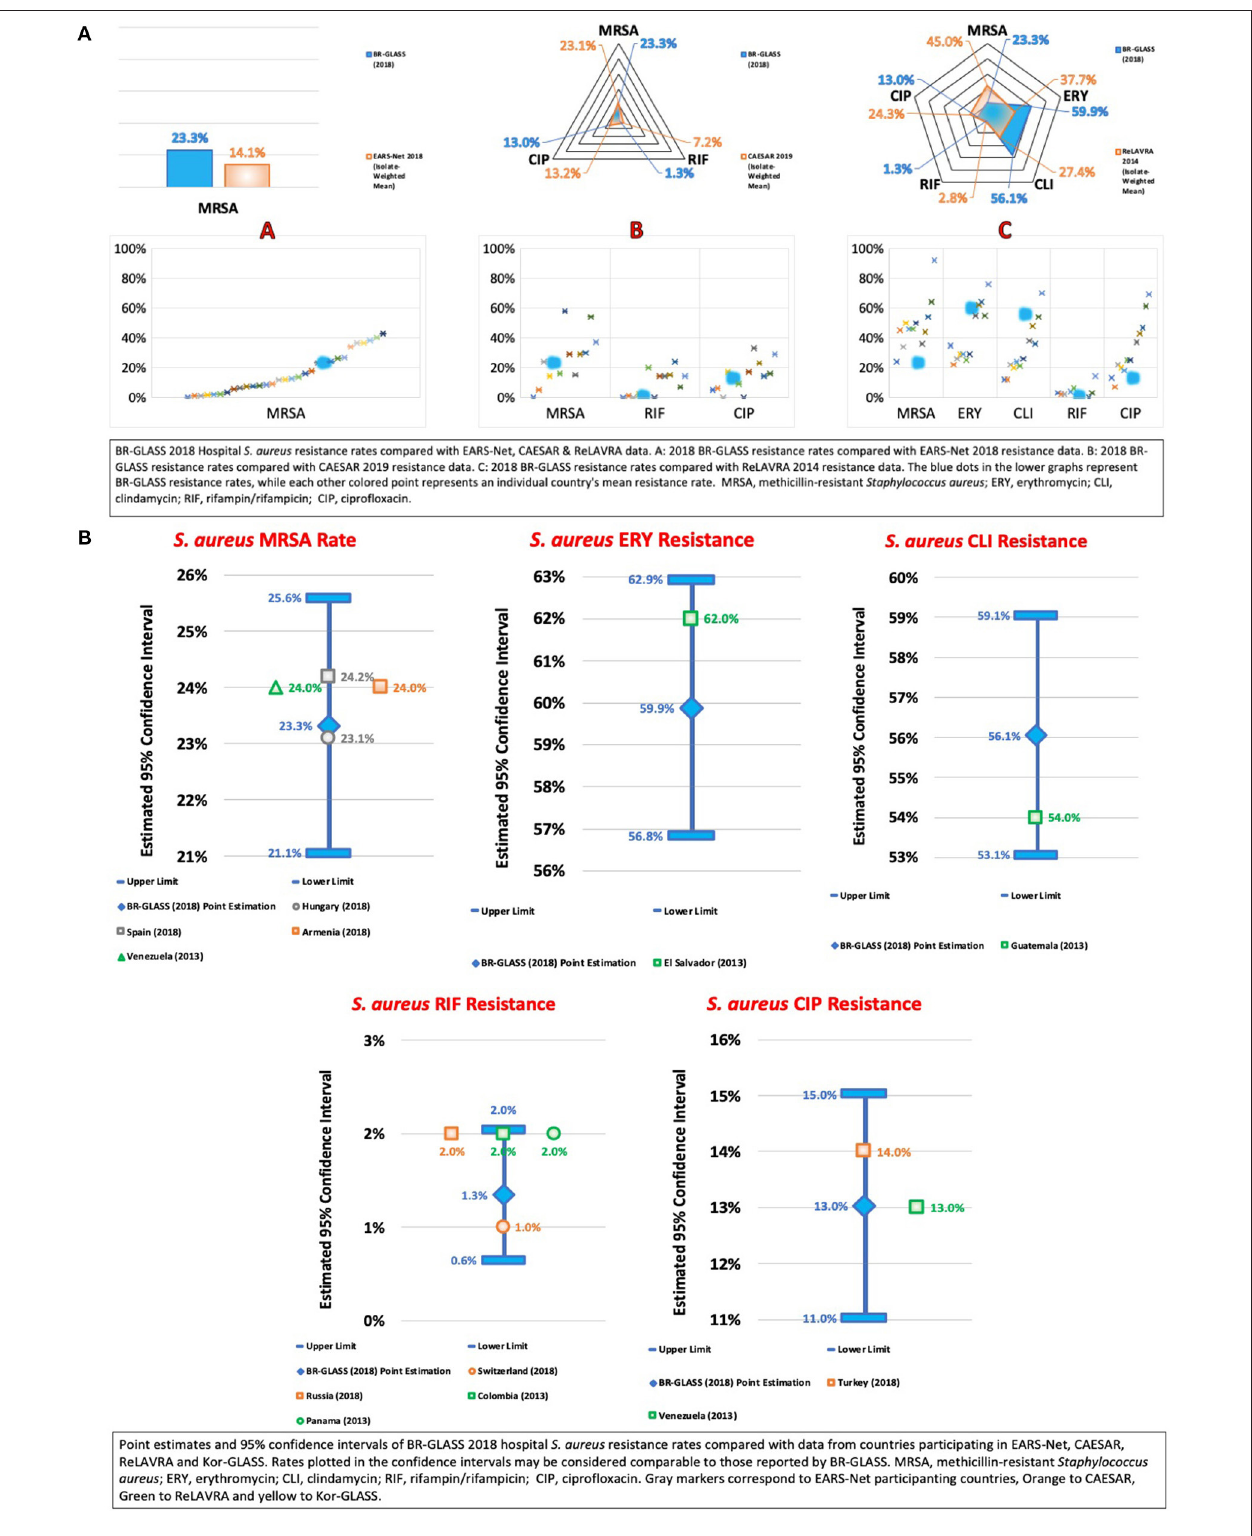
FIGURE 12 | (A) BR-GLASS 2018 Hospital S. aureus resistance rates compared with general EARS-Net, CAESAR, and ReLAVRA data. (B) BR-GLASS 2018 Hospital S. aureus estimated resistance rates with 95% confidence intervals and comparable rates reported in different countries.